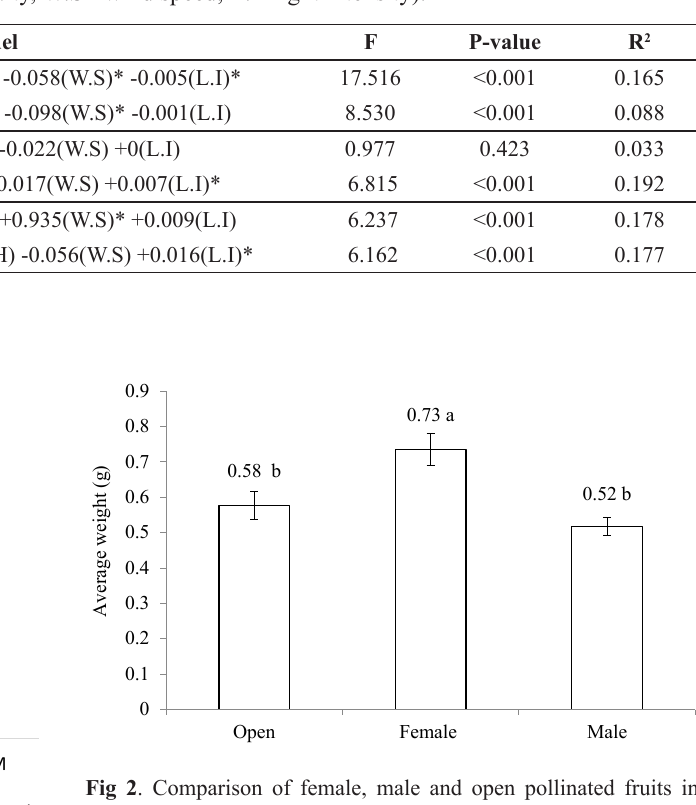
Fig 1 . Diurnal dynamic pattern of Female and male M. cephalotes in terms of average individuals per plant per 120 seconds.